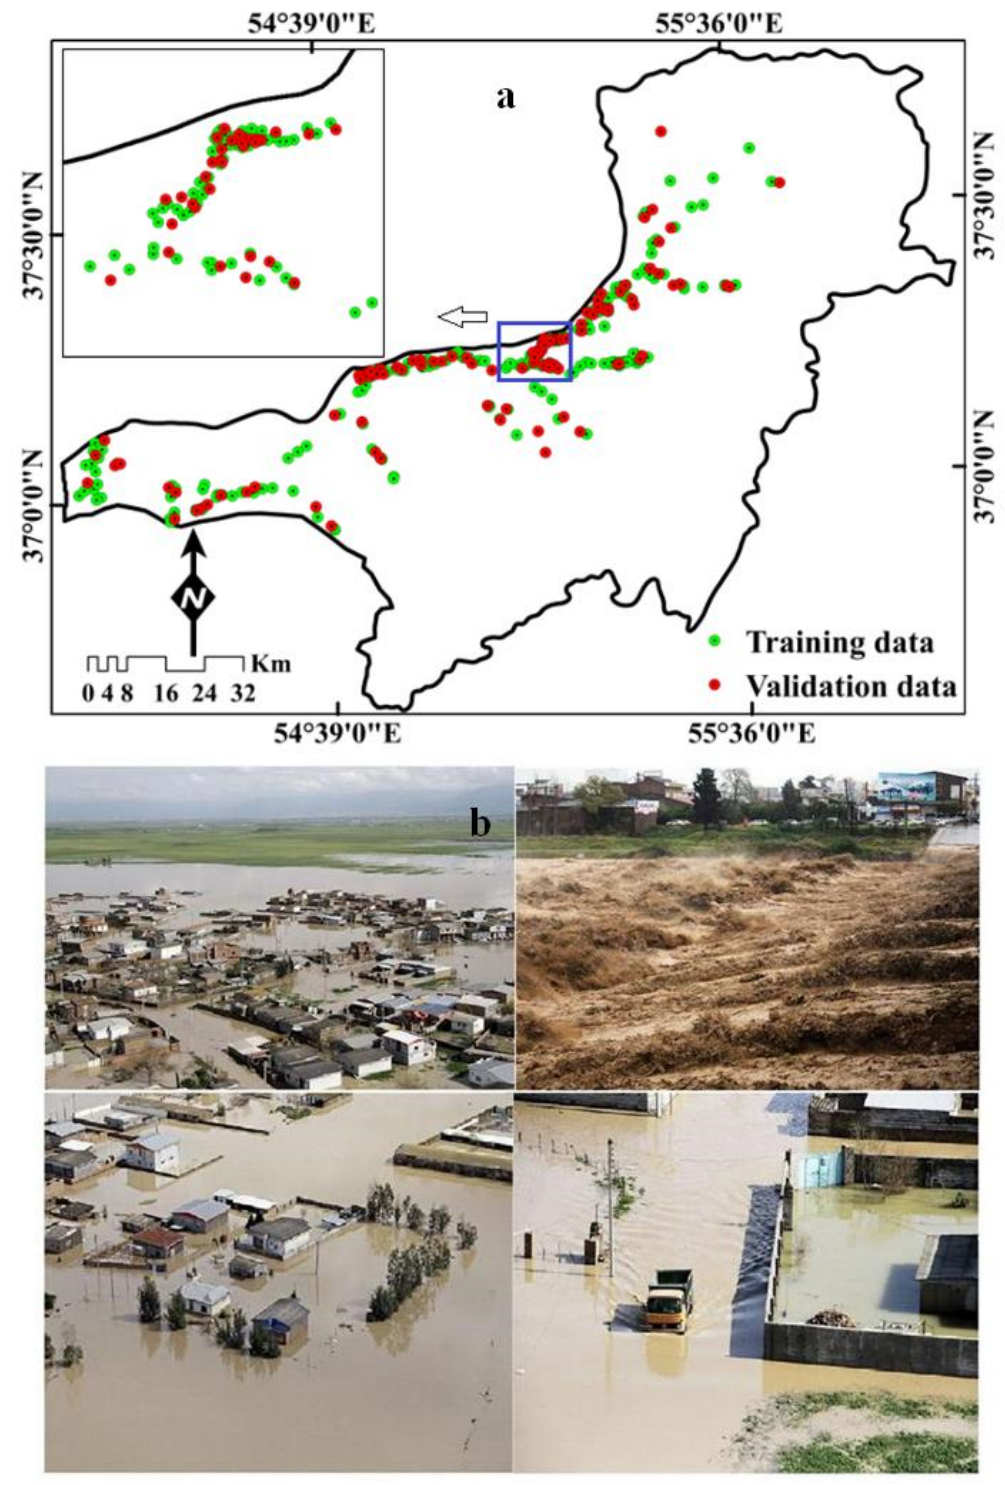
Figure 3. Flood inventory map ( a ) flooded area in the city of Aqqala ( b ).